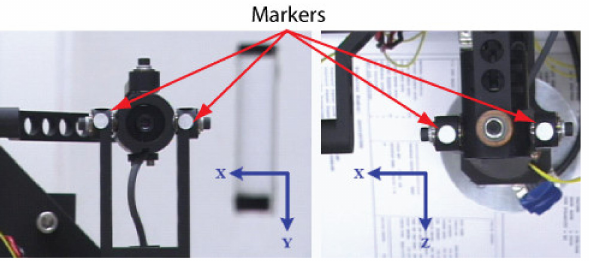
Figure 30. Markers installed on the longitudinal axis for observing mechanical distortion. Front markers ( left ). Top markers ( right